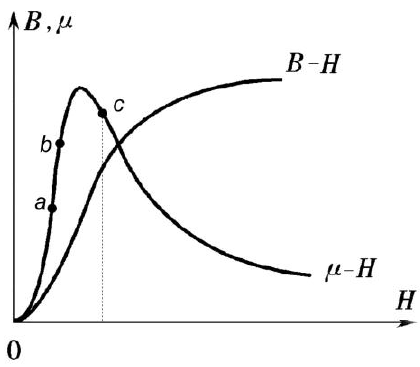
Figure 4. Relationship between magnetic conductivity μ, magnetic field strength H and magnetic flux density B.